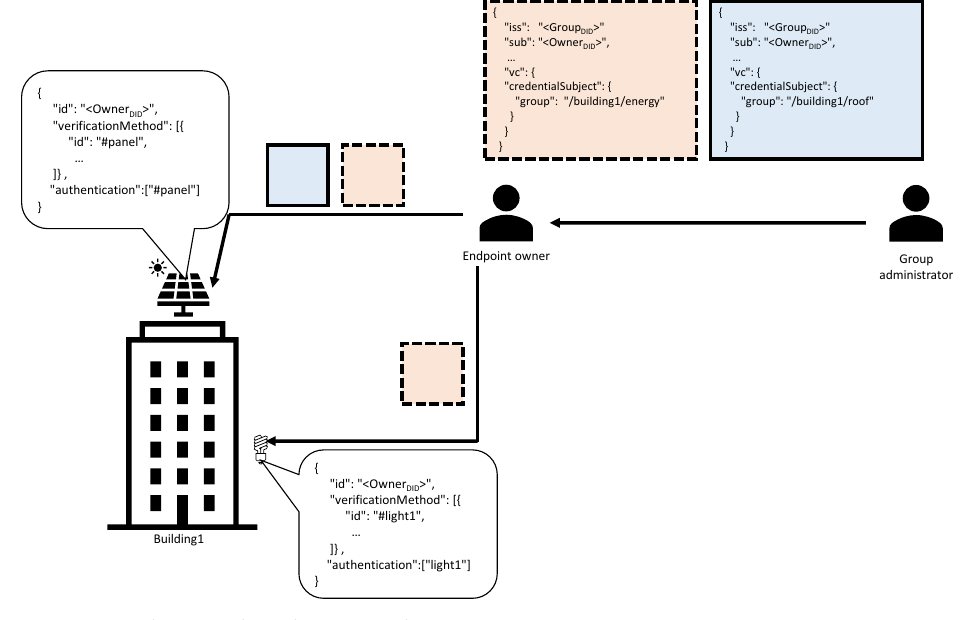
Figure 1. Endpoint onboarding